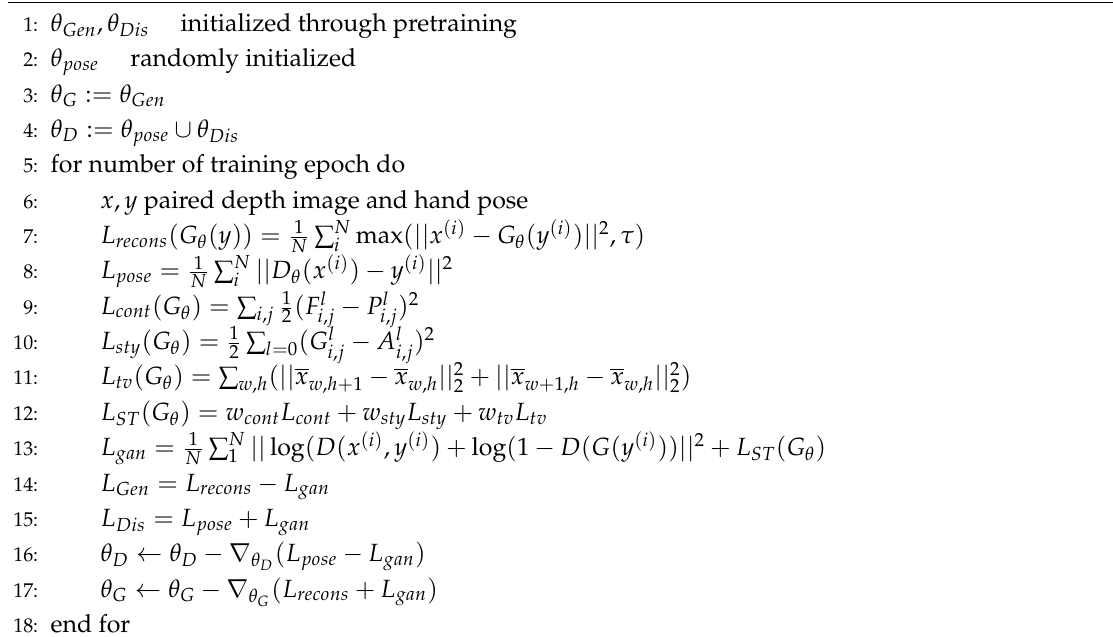
Algorithm 1 Generate depth hand image via GAN and Style